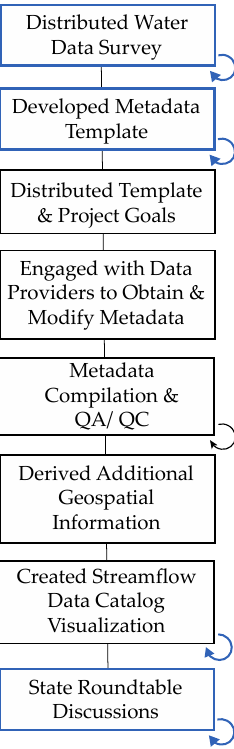
Figure 1. Workflow for distributing metadata template, compiling and QA/QC of metadata, and development of Streamflow Data Catalog. Blue boxes denote stakeholder advisory board input, and arrows denote the aspects of the workflow that required continual revision.